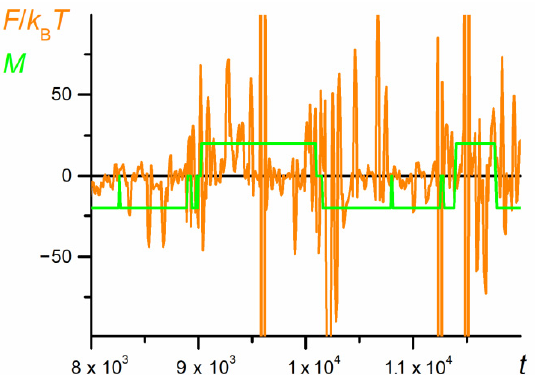
Figure 4. The dependence of the net force acting of the chain on the number of MC steps (fragment of the trajectory from Figure 2, N = 100, ε PP / k B T = − 1 and 0 for P1 and P2, respectively, D = 3 b ). The mutual orientation parameter, M, along the x direction is marked in green. The chart is based on the data recorded in periods of t E = 10 3 elementary steps.